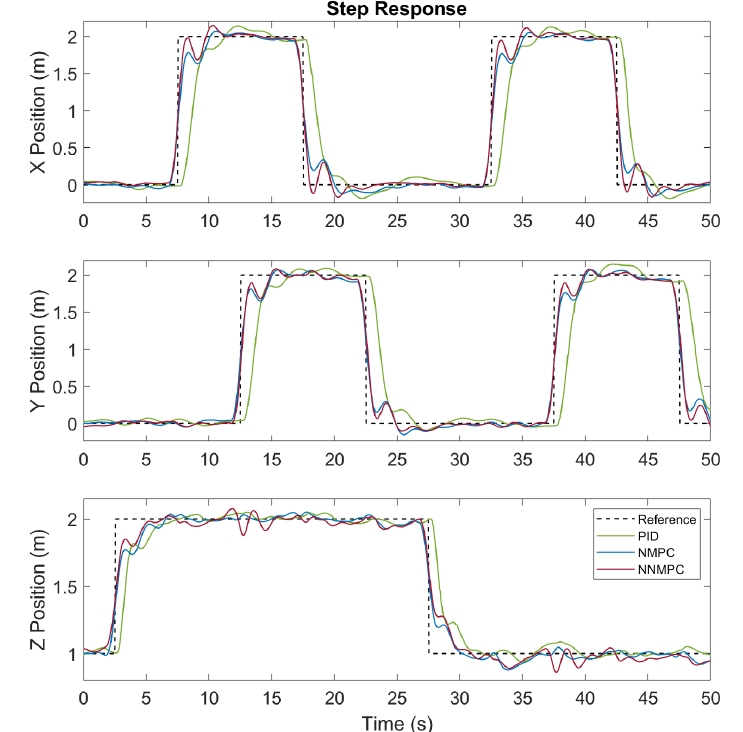
Figure 11. Step trajectory tracking results for PID, NMPC, and NNMPC controllers in three axes from the flight